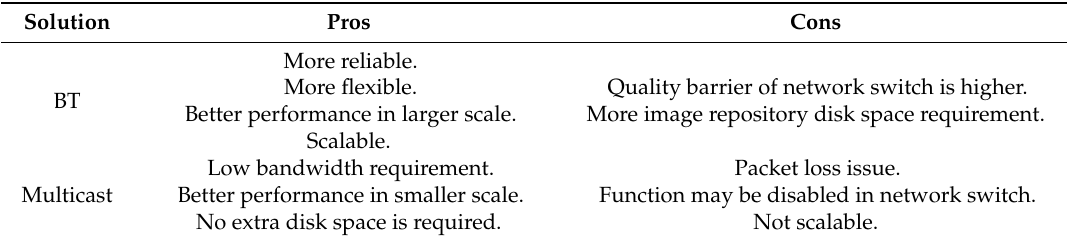
Table 5. Comparisons of the BT and multicast solutions.